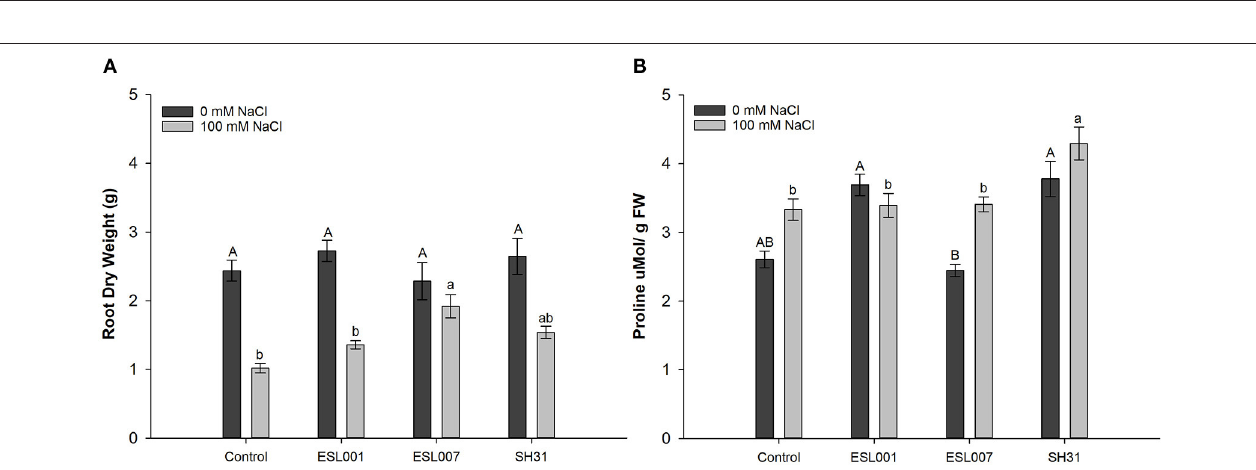
FIGURE 1 | Principal component Analyses (PCA) of bacterial treatments based on growth and biochemical parameters evaluated in the lettuce pot experiment under salt conditions (100mM NaCl in the soil). Vector Colors: red—growth parameters, green—biochemical parameters; Symbols: square—Control condition (0mM NaCl), circle—salt condition (100mM NaCl). Car, content of carotenoids; Chl, content of chlorophyll (a, b or total as indicated in the figure); DW, dry weight; FW, fresh weight.